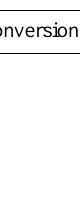
Table 2. Percentage of NO 2 converted to ozone in the converter unit cells for different levels of NO 2